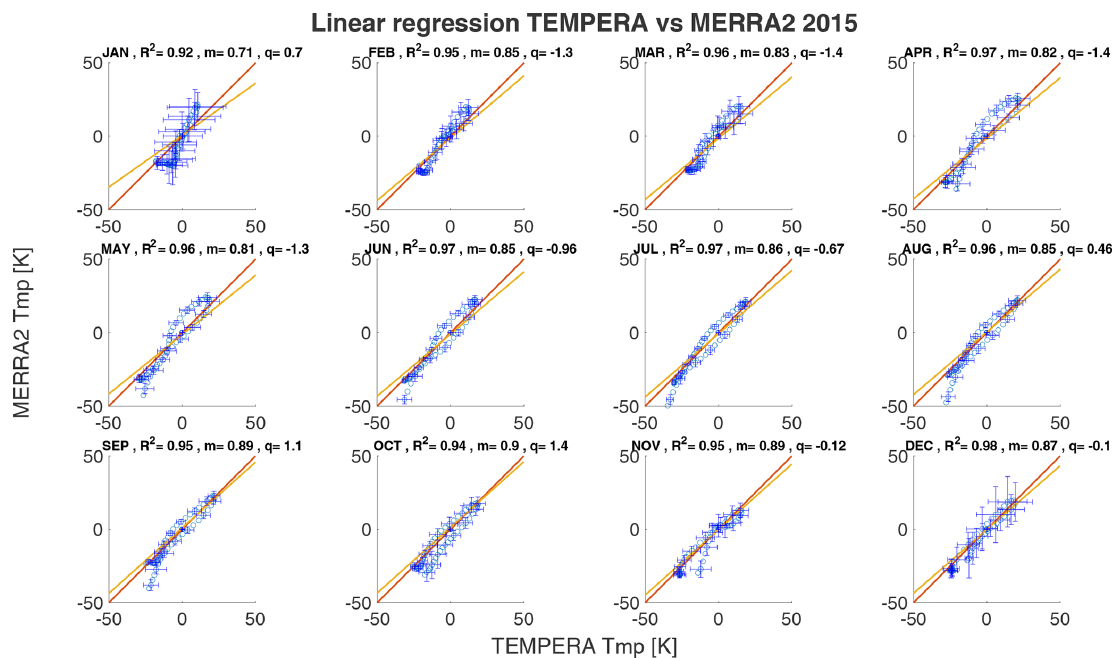
Figure A3. Linear regression of TEMPERA against MERRA2 temperatures for the year